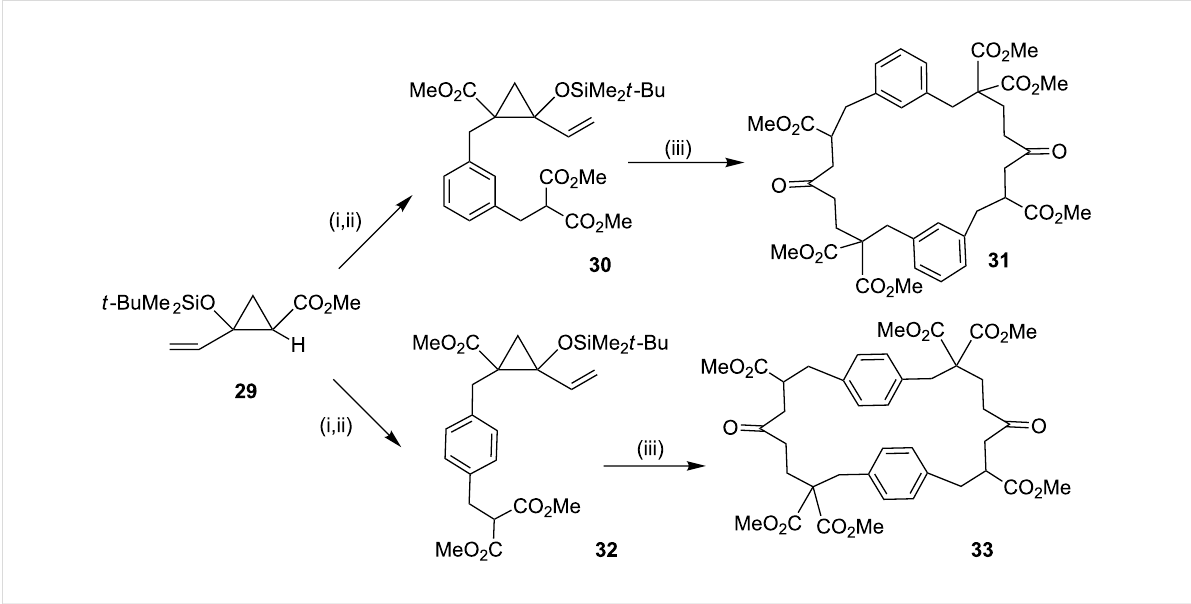
Scheme 2: Synthesis of cyclophanes through Michael addition. Reagents and conditions: (i) xylylene dibromide, LDA, − 70 °C, 18 h; (ii) NaH, CH